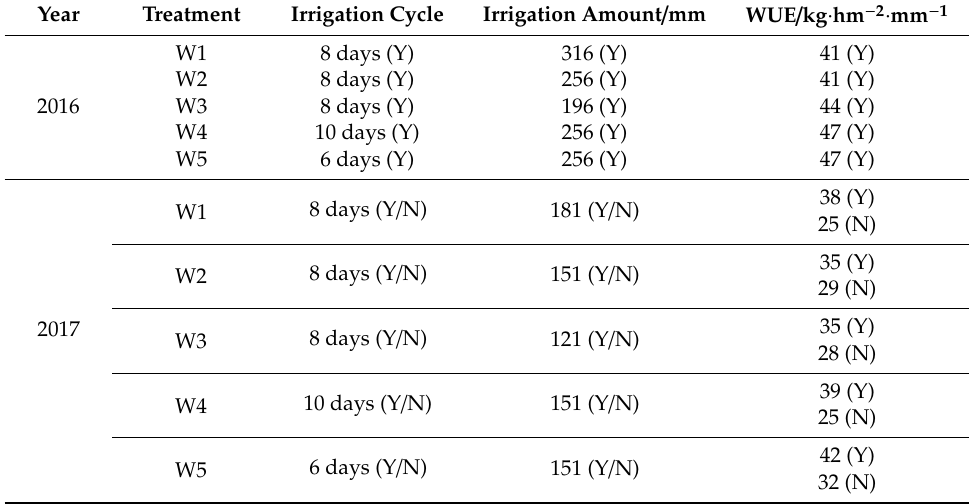
Table 2. Description of experiments in 2016 and 2017 on mulched and non-mulched plots in Xinjiang, China.